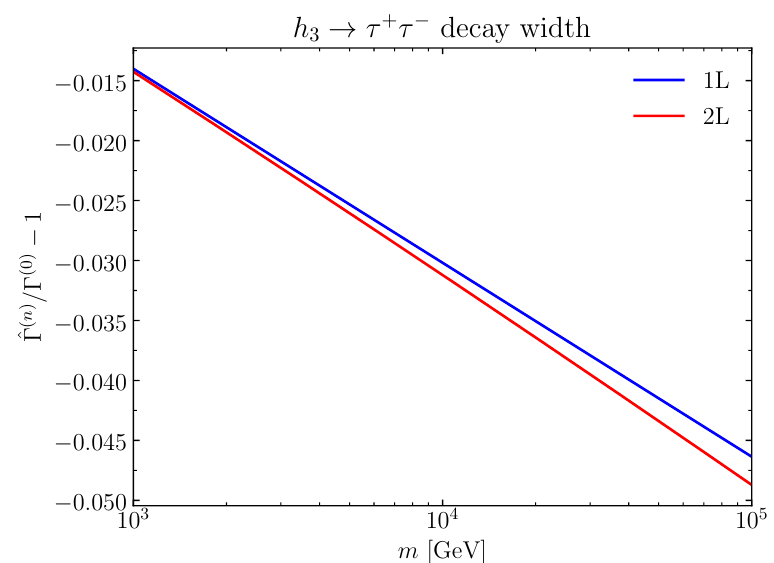
Figure 15. One-loop and two-loop external leg corrections to the h 3 → τ + τ − decay width in the N2HDM relative to the tree-level result as a function of the heavy mass scale m (see text). The input values in this plot are (cid:15) = (50 GeV ) 2 , tan β = 1 . 4 , s α